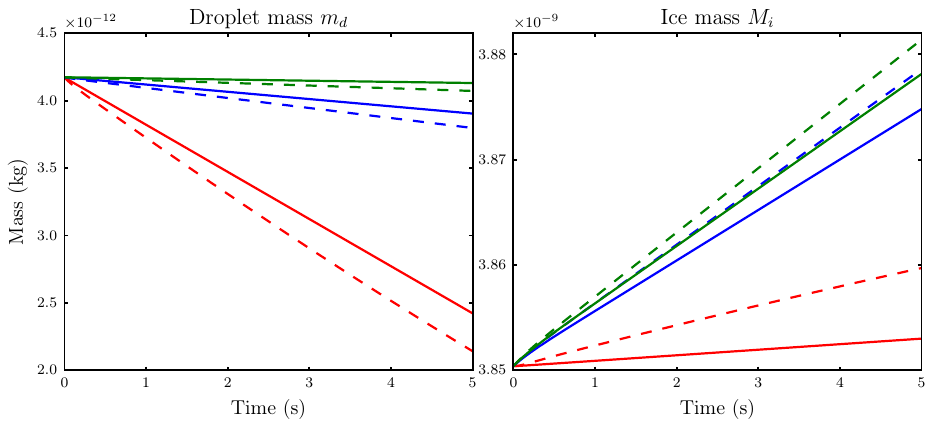
Figure 4. Comparison of the temporal evolution of hydrometeor masses obtained with the new model from Eq. (19) with parameter value n = 1 . 8 (dashed) and the reference model (solid) for the case of N d = 14 droplets per influence sphere. Ambient saturation ratios are S ∞ = 0 . 86 (red), S ∞ = 0 . 99 (blue) and S ∞ = 1 . 01 (green).